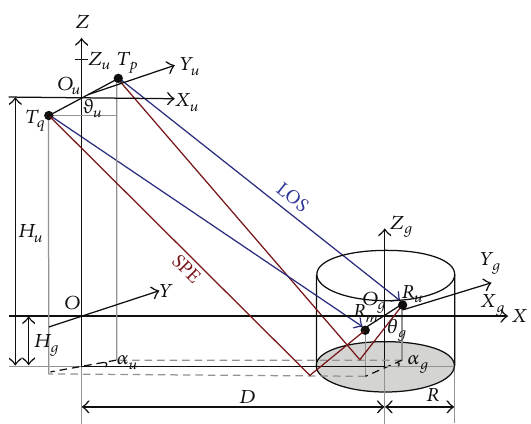
Figure 1: Communication model of LOS and SPE components.